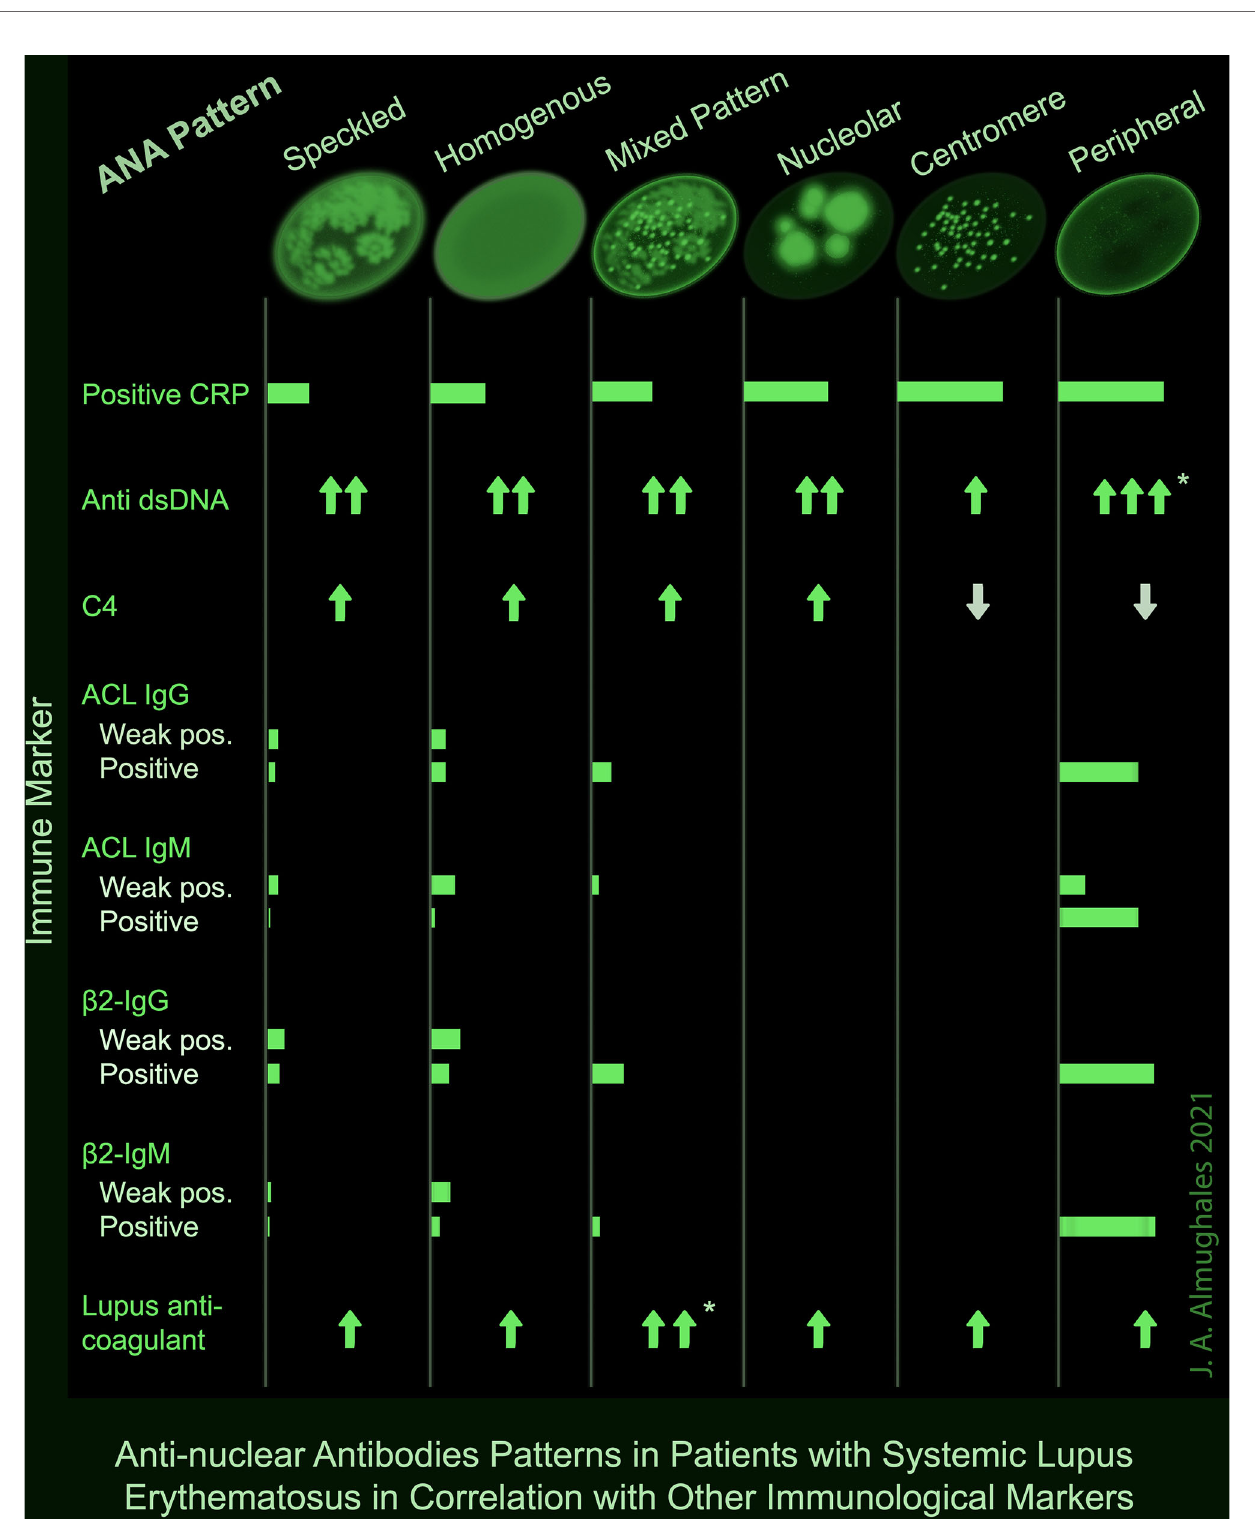
FIGURE 1 | Summary of the signi fi cant associations of ANA patterns with other immune markers in patients with SLE. * Signi fi cance con fi rmed by post hoc analysis.